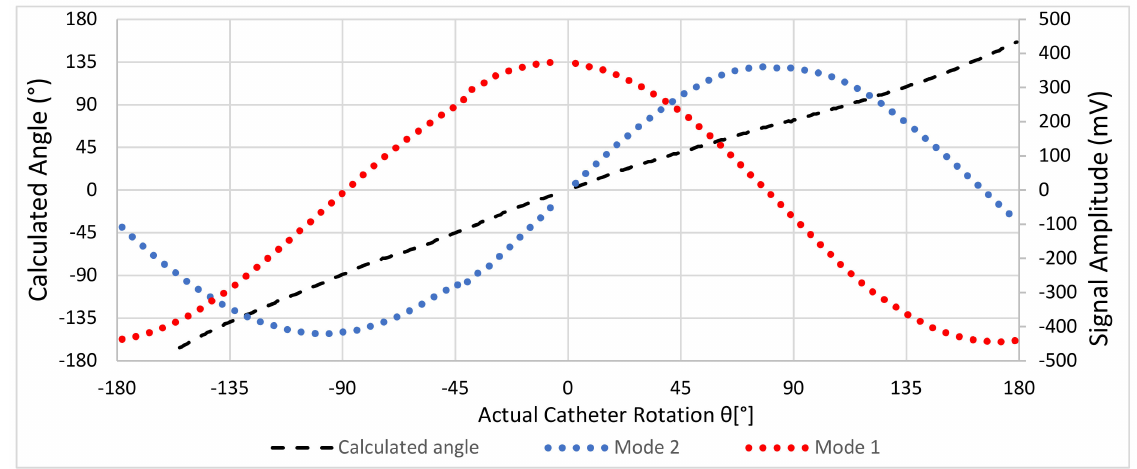
Figure 10. Measured signals and calculated alignment angle as a function of alignment angle in a saline